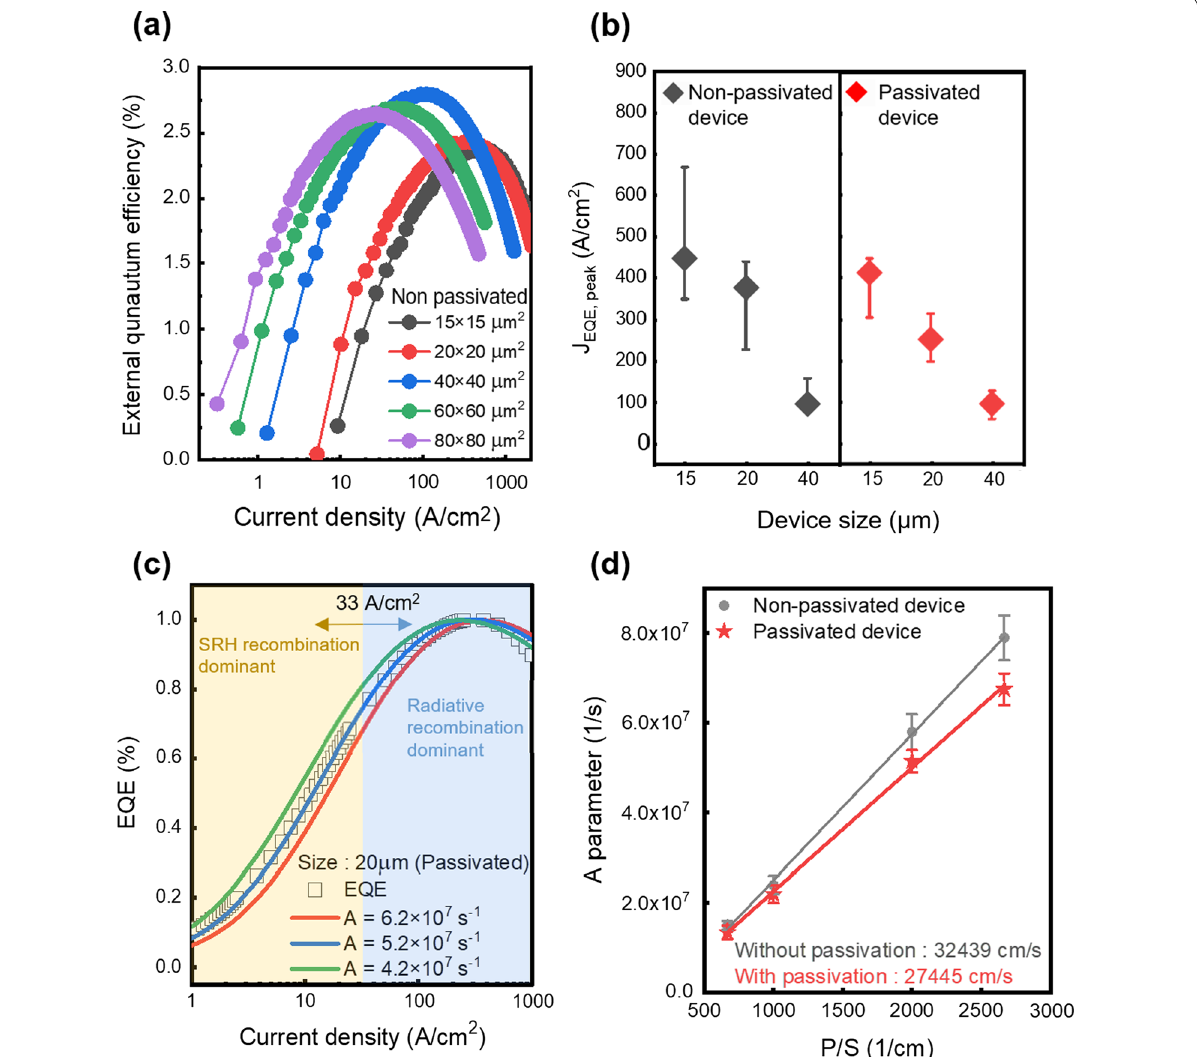
Fig. 3 a Size‑dependent EQE of AlGaInP/GaInP micro‑LED. b Peak current density of LED devices (symbol) and the current density range 1% apart from peak current density (line) with (left) and without passivation (right). c The EQE plot fitting based on the ABC model. d Size‑dependent SRH parameters were used in fitting the EQE curves with and without passivation. The surface recombination velocity is extracted from the